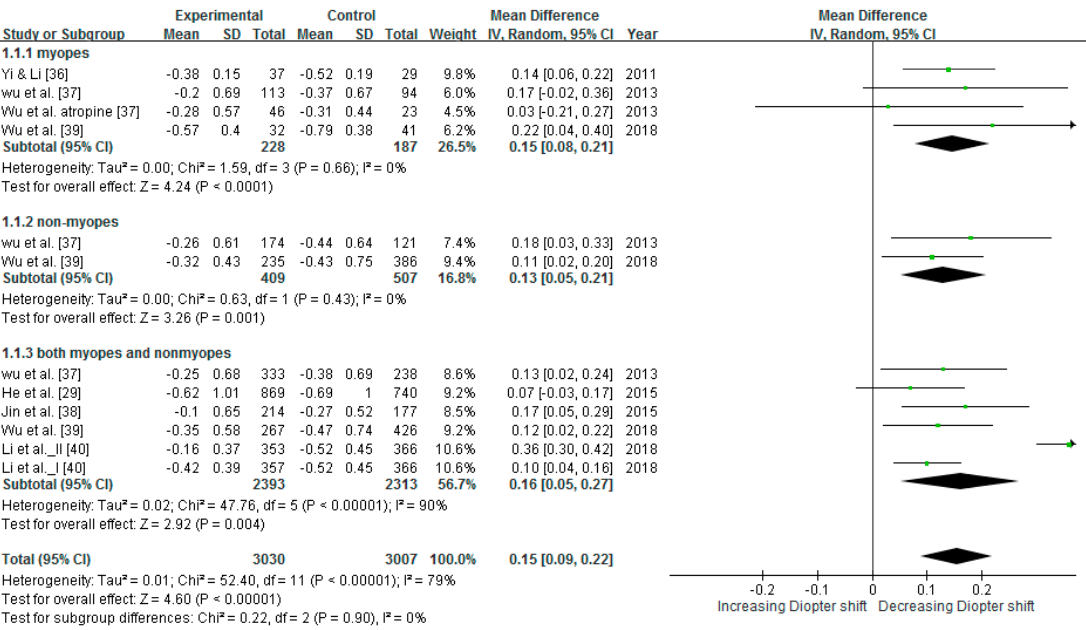
Figure 3. Results of meta-analysis for SER after interventions.